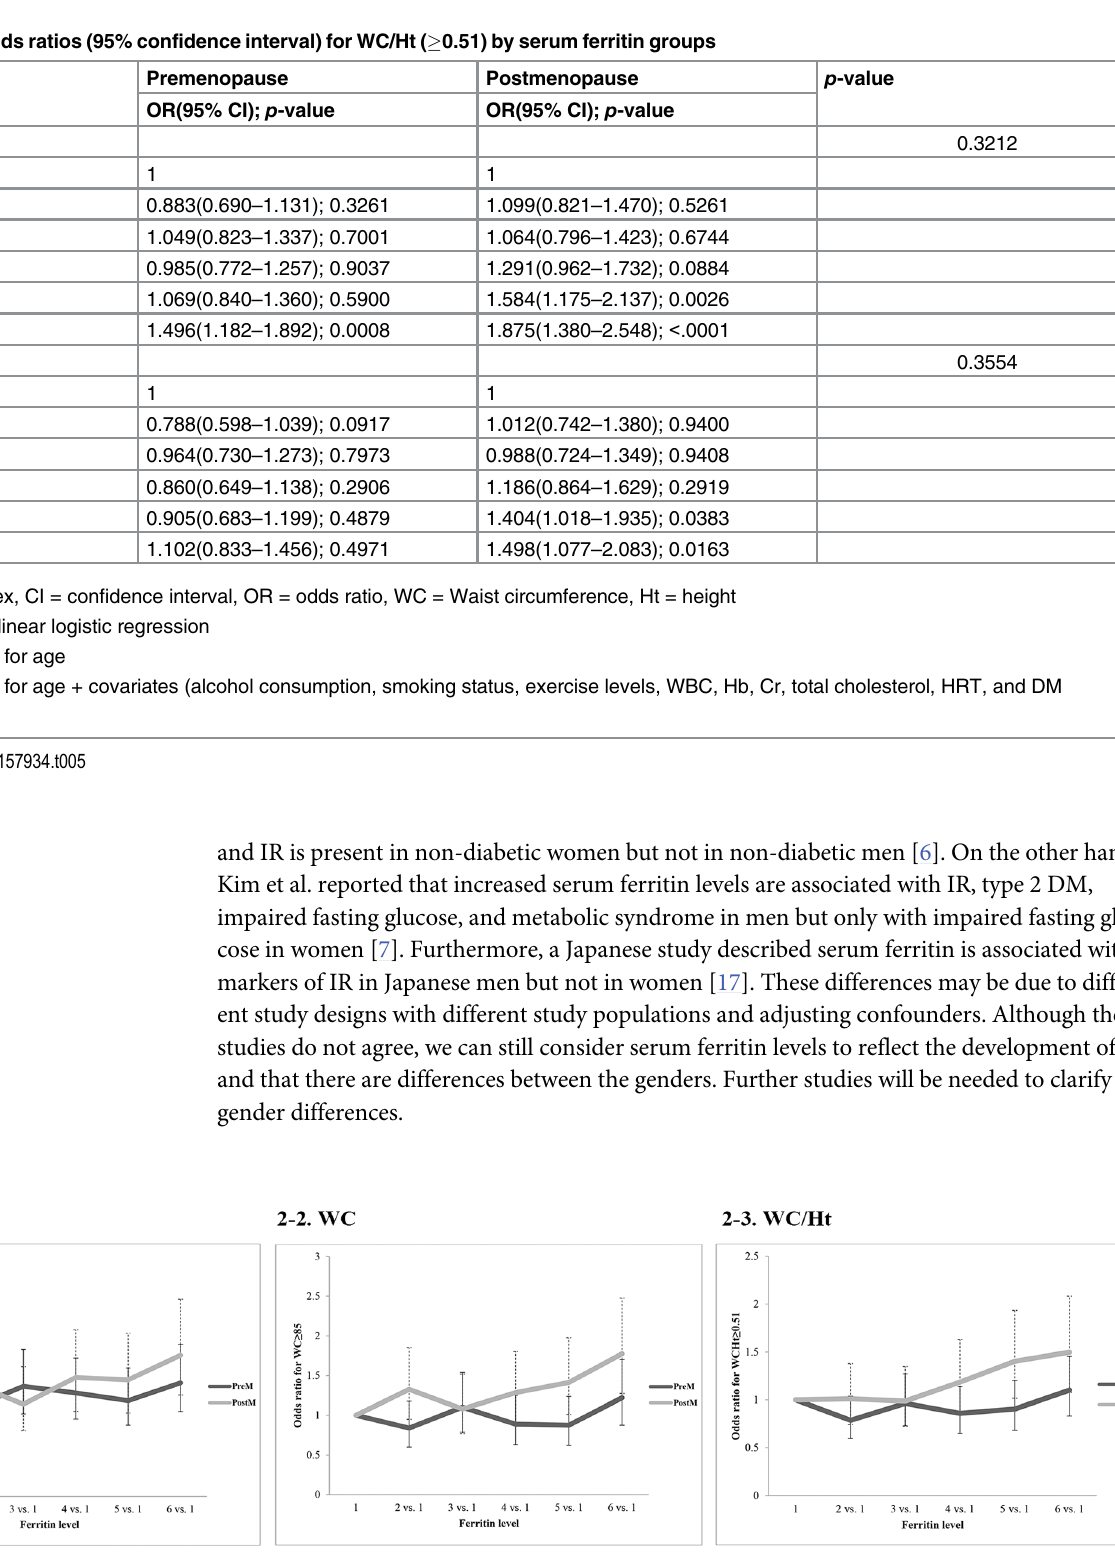
Fig 2. Odds ratio estimates for obesity indices according to serum ferritin groups after adjusting with confounders.